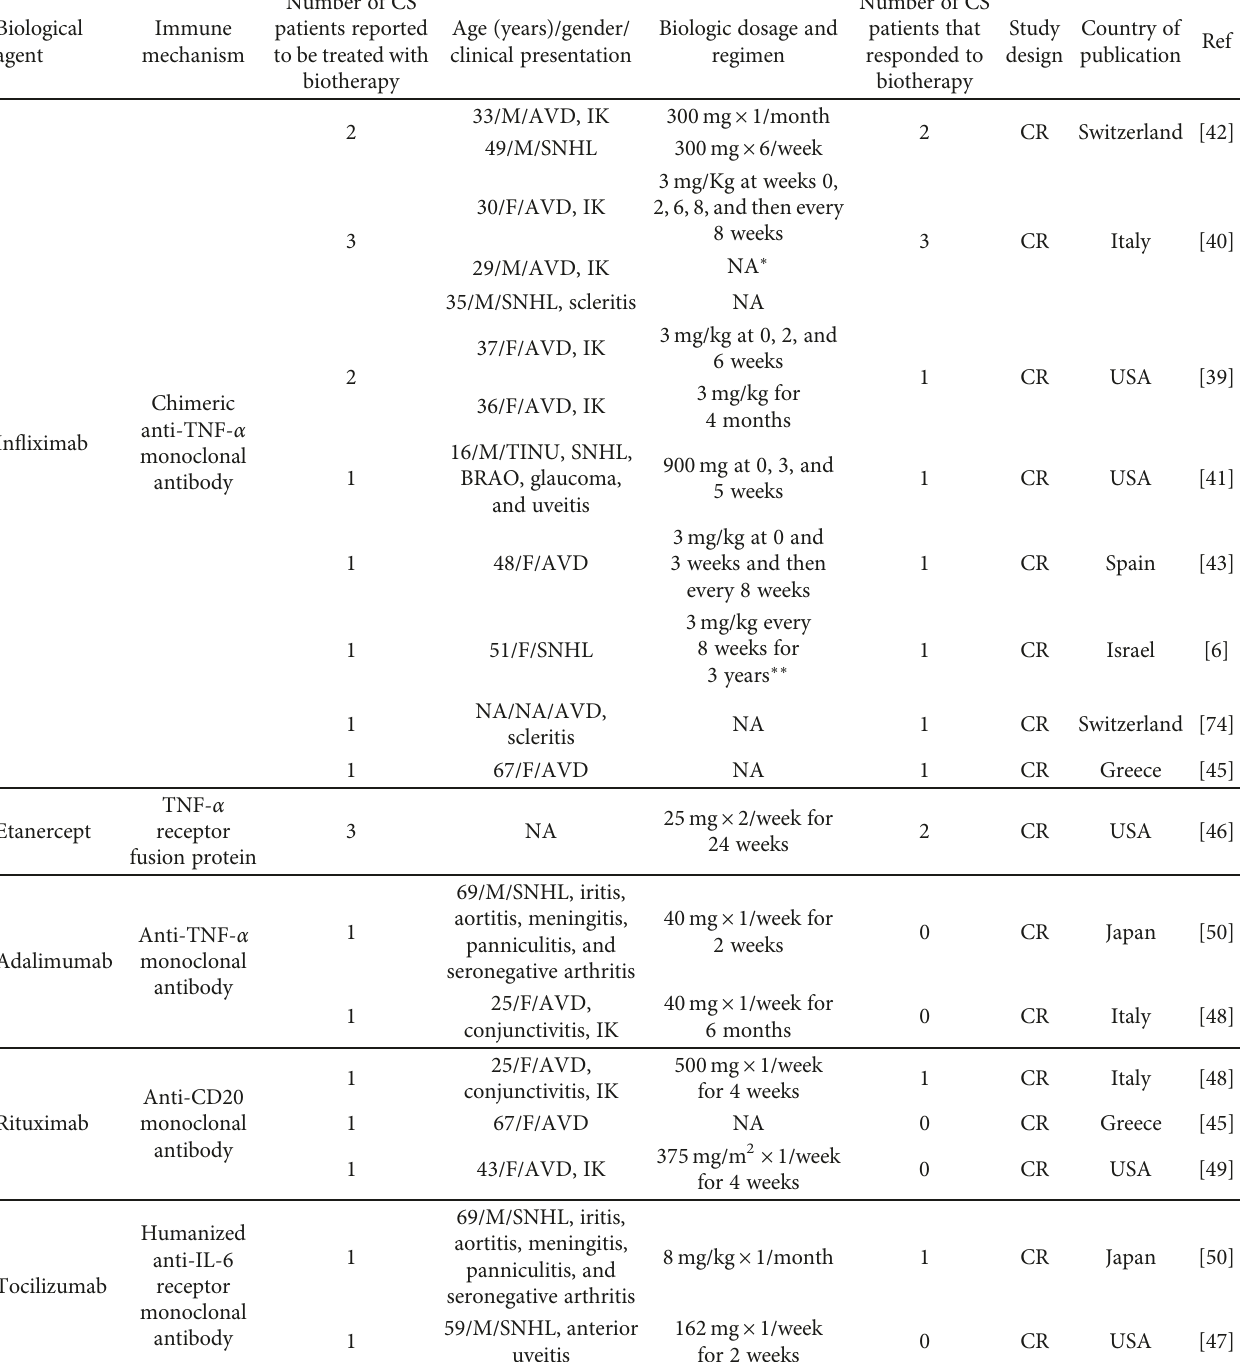
Table 2: Evidence for treatment of Cogan ’ s syndrome with biological